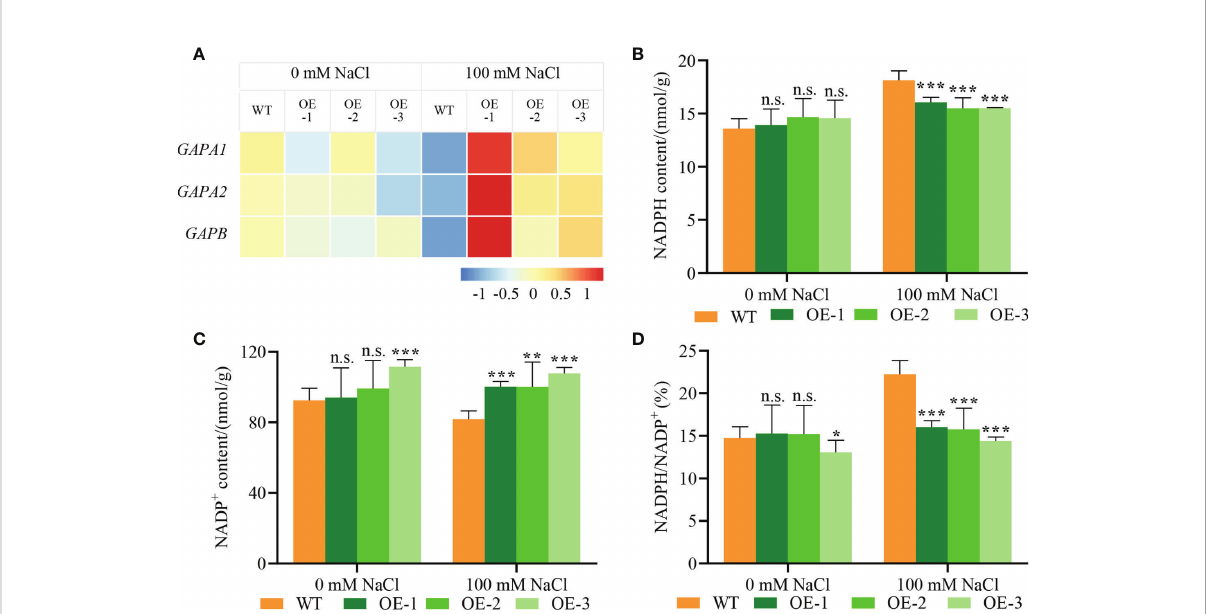
FIGURE 8 NbCIPK25 enhances the transcription of key genes in the Calvin cycle. (A) The transcription trends of GAPDHs shown as colored boxes from qPCR results. AtUBQ10 was taken as internal standard. The gene expression levels were normalized to the gene expressing in WT under 0 mM NaCl treatment for calculating foldchanges of expression levels. Colored bar with values under the panel A was used to evaluate gene expression level. Blue boxes mean downregulated expression; red boxes mean upregulated expression. (B – D) NADPH content (B) , NADP + content (C) and NADPH/NADP + (D) of 5-day-old WT and transgenic plants under 0 mM NaCl or 100 mM NaCl for 2 days, data represent means ± SD from three biological replicates, t-test used for statistical analysis, ‘ * ’ p < 0.05, ‘ ** ’ p < 0.01, ‘ *** ’ p < 0.001, n.s., not signi fi